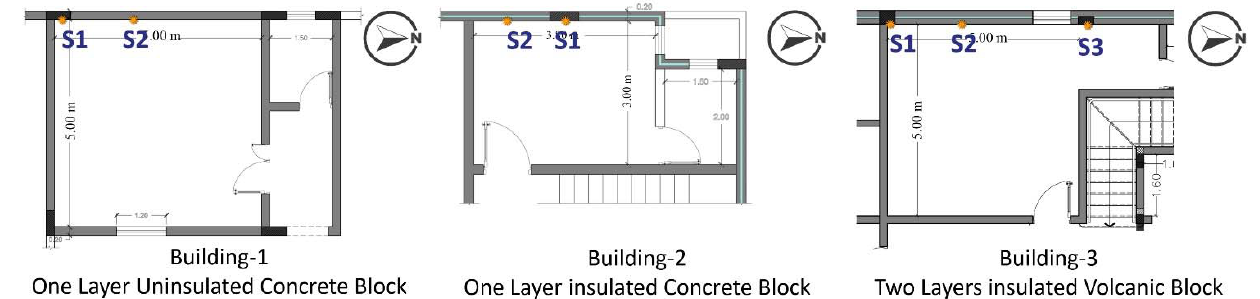
Figure 2. Three rooms of buildings investigated in this research. Sensors S1, S3 on concrete columns and S2 on in ‐ fill wall.